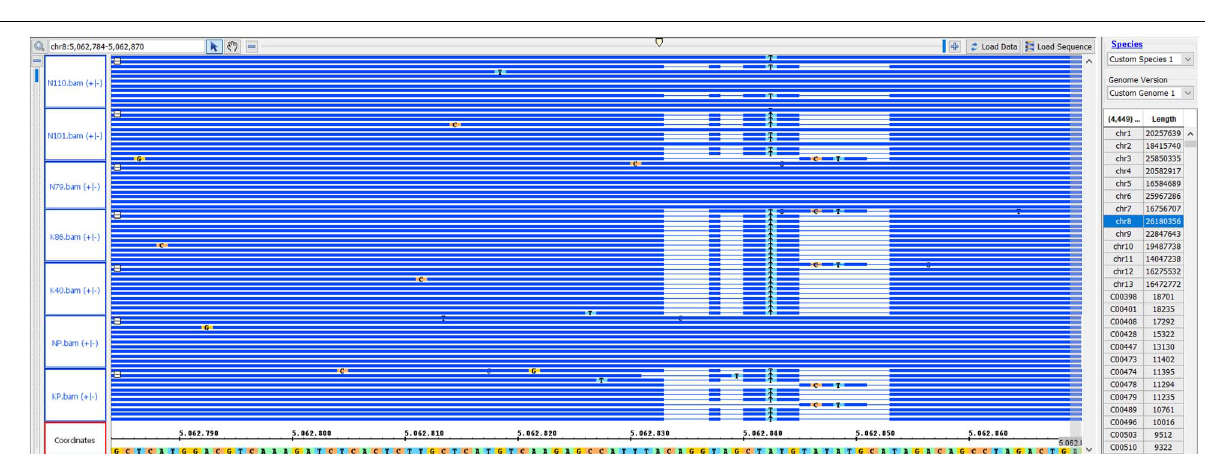
FIGURE 3 | Detailed graphics for the position of the capsule shattering trait (phenotype) on LG8.